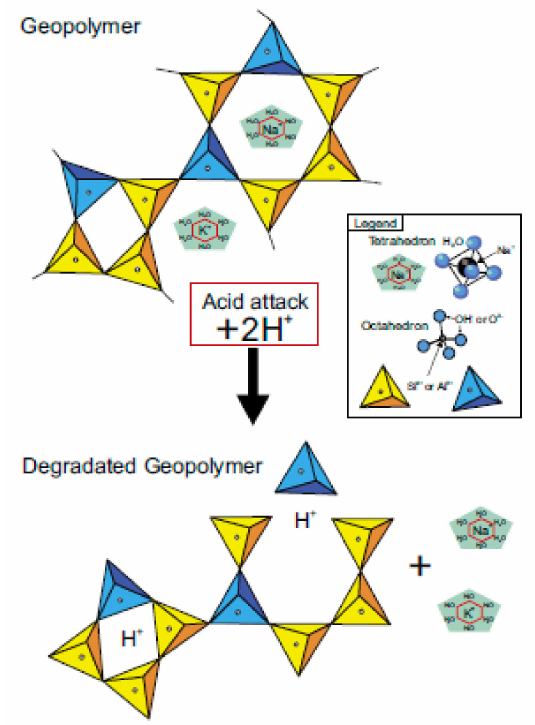
Figure 8. Geopolymer resistance to acid attacks [17]. “Reproduced with permission from Zhu, J.; I Mackie, R.; Riskowski, G.L., Int. Biodeterior. Biodegradation ; published by Elsevier,